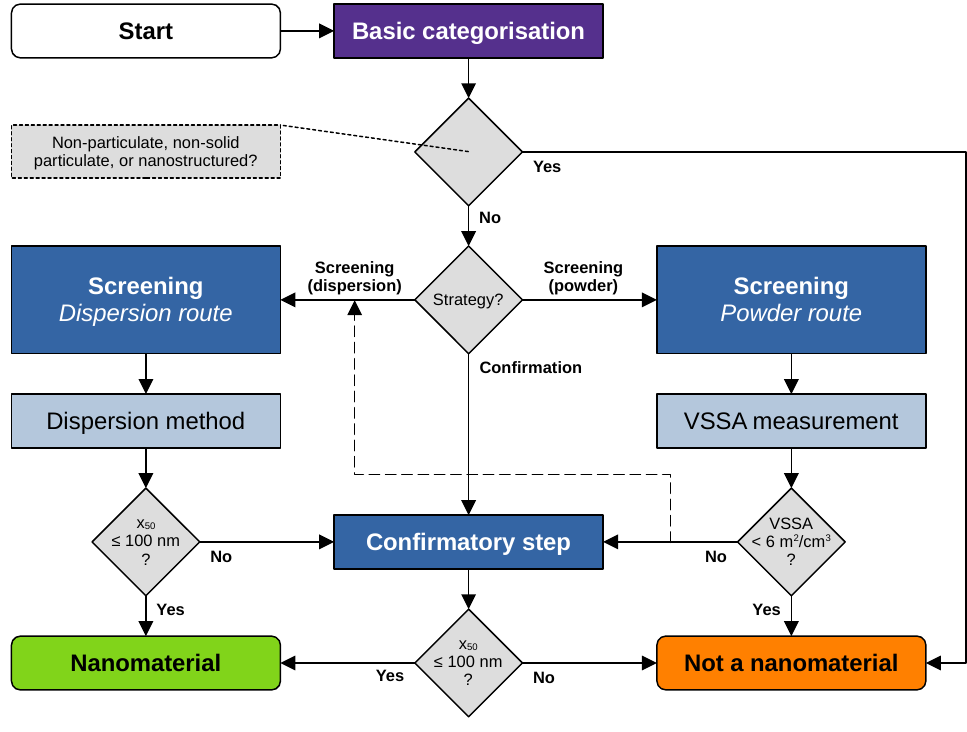
Figure 1. Updated analysis and decision flow scheme following the 2022-Recommendation for the definition of a nanomaterial. x 50 is the median of the particle number-based size distribution, used here as short form for x 50,0